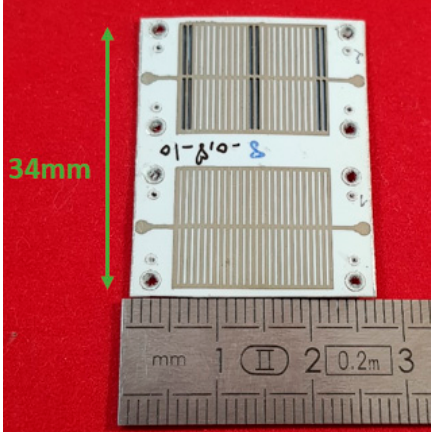
Figure 9. Illustration of the structure with the sensitive layers located at the maximum electric (E) fields of both modes.